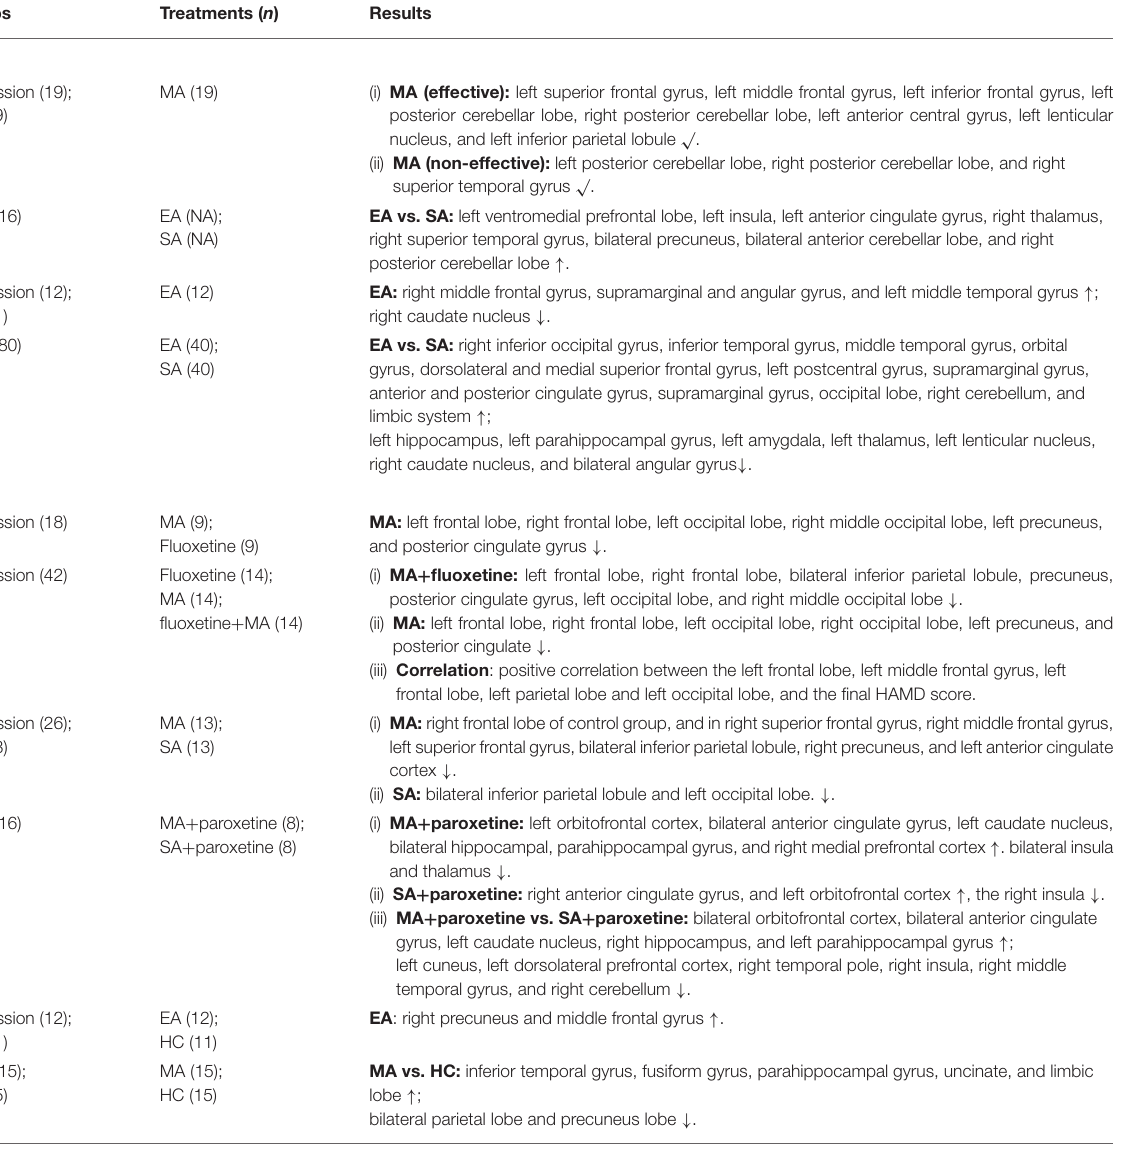
Depression (19); MA (19) (i) MA (effective): left superior frontal gyrus, left middle frontal gyrus, left inferior frontal gyrus, left HC (19) posterior cerebellar lobe, right posterior cerebellar lobe, left anterior central gyrus, left lenticular nucleus, and left inferior parietal lobule √ . (ii) MA (non-effective): left posterior cerebellar lobe, right posterior cerebellar lobe, and right superior temporal gyrus √ . EA (NA); EA vs. SA: left ventromedial prefrontal lobe, left insula, left anterior cingulate gyrus, right thalamus, SA (NA) right superior temporal gyrus, bilateral precuneus, bilateral anterior cerebellar lobe, and right posterior cerebellar lobe . ↑ EA (12) EA: right middle frontal gyrus, supramarginal and angular gyrus, and left middle temporal gyrus ; ↑ right caudate nucleus . ↓ EA vs. SA: right inferior occipital gyrus, inferior temporal gyrus, middle temporal gyrus, orbital SA (40) gyrus, dorsolateral and medial superior frontal gyrus, left postcentral gyrus, supramarginal gyrus, anterior and posterior cingulate gyrus, supramarginal gyrus, occipital lobe, right cerebellum, and limbic system ; ↑ left hippocampus, left parahippocampal gyrus, left amygdala, left thalamus, left lenticular nucleus, right caudate nucleus, and bilateral angular gyrus . ↓ MA (9); MA: left frontal lobe, right frontal lobe, left occipital lobe, right middle occipital lobe, left precuneus, Fluoxetine (9) and posterior cingulate gyrus . ↓ posterior cingulate gyrus, left occipital lobe, and right middle occipital lobe . ↓ (ii) MA: left frontal lobe, right frontal lobe, left occipital lobe, right occipital lobe, left precuneus, and posterior cingulate . ↓ (iii) Correlation : positive correlation between the left frontal lobe, left middle frontal gyrus, left frontal lobe, left parietal lobe and left occipital lobe, and the final HAMD score. MA (13); (i) MA: right frontal lobe of control group, and in right superior frontal gyrus, right middle frontal gyrus, SA (13) leftsuperiorfrontalgyrus,bilateralinferiorparietallobule,rightprecuneus,andleftanteriorcingulate cortex . ↓ (ii) SA: bilateral inferior parietal lobule and left occipital lobe. . ↓ MA paroxetine (8); (i) MA + paroxetine: left orbitofrontal cortex, bilateral anterior cingulate gyrus, left caudate nucleus, + SA paroxetine (8) bilateral hippocampal, parahippocampal gyrus, and right medial prefrontal cortex . bilateral insula + ↑ and thalamus . ↓ (ii) SA + paroxetine: right anterior cingulate gyrus, and left orbitofrontal cortex , the right insula . ↑ ↓ (iii) MA + paroxetine vs. SA + paroxetine: bilateral orbitofrontal cortex, bilateral anterior cingulate gyrus, left caudate nucleus, right hippocampus, and left parahippocampal gyrus ; ↑ left cuneus, left dorsolateral prefrontal cortex, right temporal pole, right insula, right middle temporal gyrus, and right cerebellum . ↓ EA (12); EA : right precuneus and middle frontal gyrus . ↑ HC (11) MDD (15); MA (15); MA vs. HC: inferior temporal gyrus, fusiform gyrus, parahippocampal gyrus, uncinate, and limbic HC (15) HC (15) lobe ; ↑ bilateral parietal lobe and precuneus lobe ↓